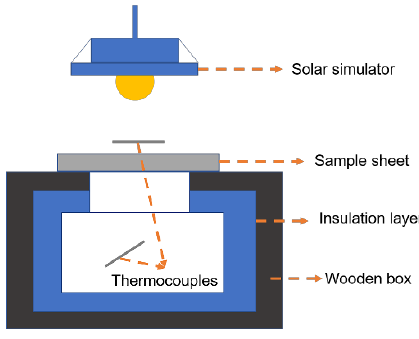
Figure 1. Self-made blackboard thermometer.